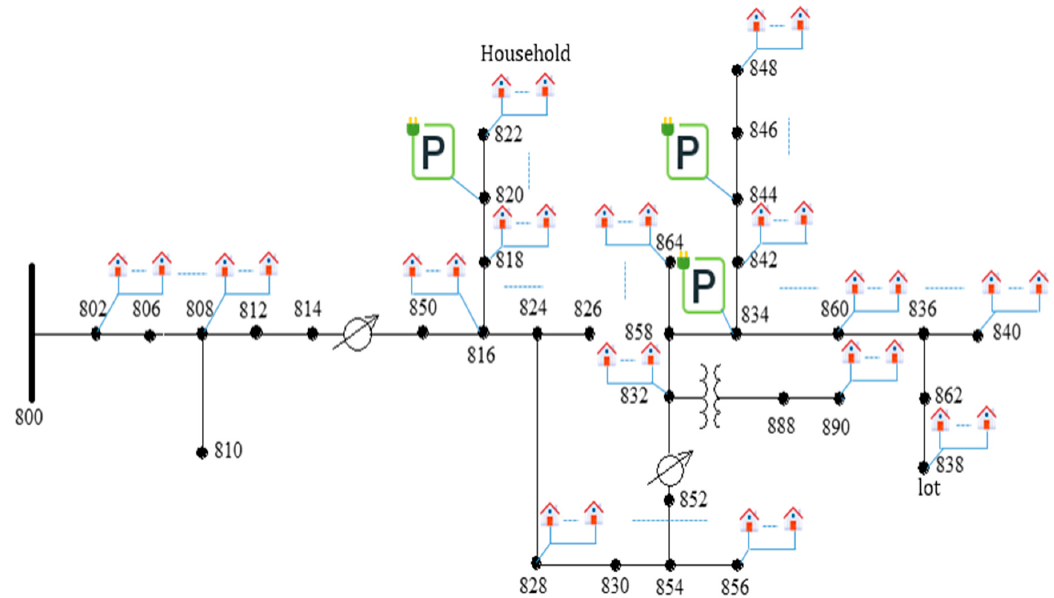
Figure 7. Modified layout of IEEE 34 node system with baseload and EV parking lot load.